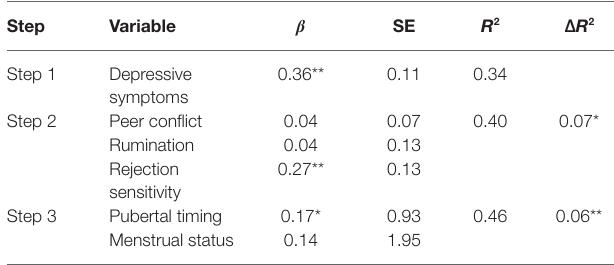
TABLE 2 | Pubertal status regression estimates predicting Time 2 depressive